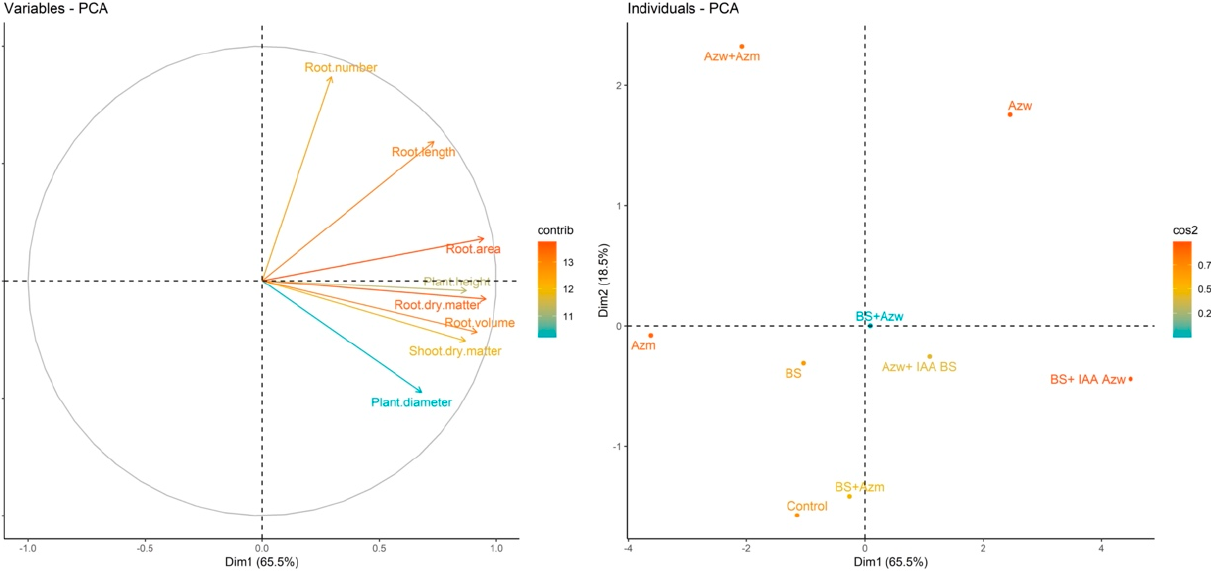
Figure 8. Main component analysis (PCA) for variables and treatments (individuals). Values on axes 1 and 2 represent the percentage of total variance explained by axes for the dgt genotype. In the hierarchical cluster analysis, the closest groups were Azm and Azw + Azm. The next groups were BS + Azm, BS + Azw, Azw + IAA BS, BS and control. The groups most distinct from the others were Azw and BS + IAA Azw (Figure 9).